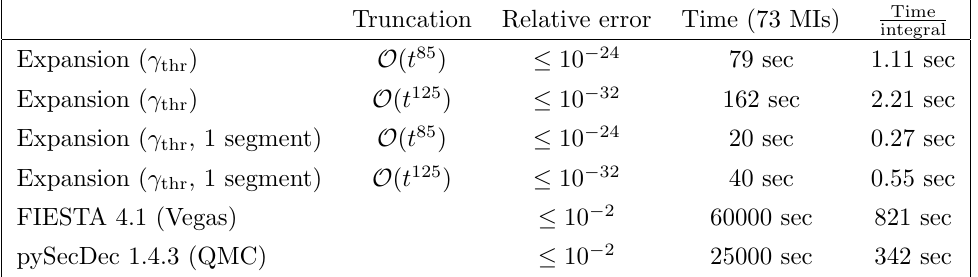
Table 1 . Timings for the computation of all the 73 master integrals in the point above threshold s 12 = 5 ; s 13 = (cid:0) 1 ; p 2 = 13 ; m 2 = 1 up to and including order (cid:15) 4 , on 1 CPU core. The point is 4 15 reached by expanding along the contour (cid:13) thr de(cid:12)ned in section 4.1. We use FIESTA 4.1 with the Vegas [80] integrator while pySecDec 1.4.3 with the quasi-Monte Carlo integrator. The ’1 segment’ lines correspond to the average time needed to perform the expansion along one of the four line segments of the contour (cid:13) thr . This timing is more representative of the typical time needed to reach a given point when several points have been already computed. Indeed, once several points have been computed (for example when performing a phase space integration) one can use as a boundary point the closest point to the next target point, which will likely be ‘close’ to an already computed point.